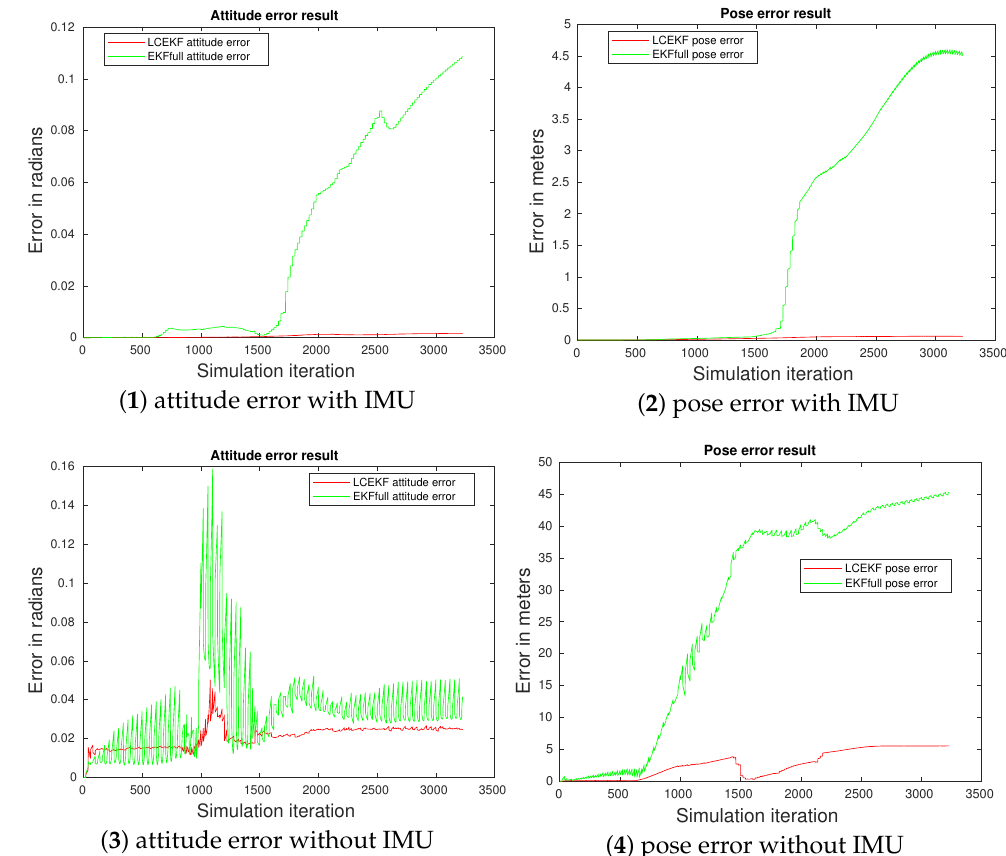
Figure 14. SLAM with periodic square noise: methods’ comparison. Figures ( 1 ) and ( 2 ) represent the MSE of the pose and attitude estimation over 10 executions for the two methods while using the IMU for prediction. Figures ( 3 ) and ( 4 ) represent the MSE of the pose and attitude estimation over 10 executions for the two methods while using a constant velocity model for prediction (no proprioceptive sensor). It can be clearly seen that the EKFfull diverged in both case.